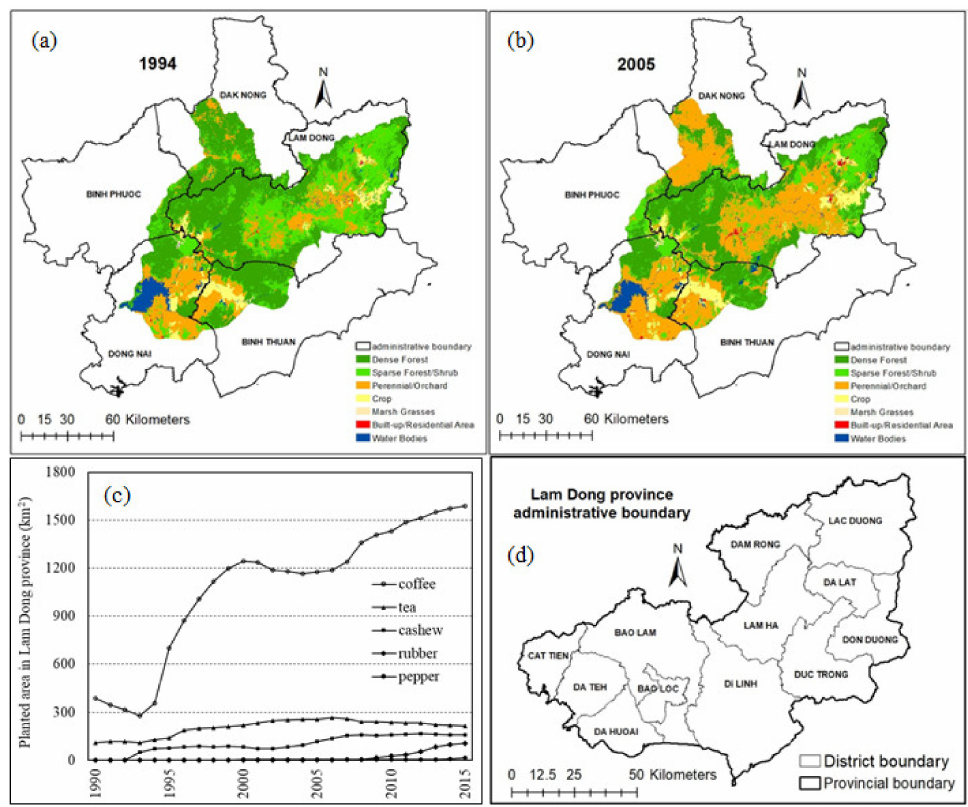
Figure 3. Land-use changes of UDNB in 1994 and 2005 ( a , b ); Trends in the planted areas of multi-year industrial crops ( c ) and administrative boundaries of Lam Dong province ( d ) (Data source: Lam Dong Statistical